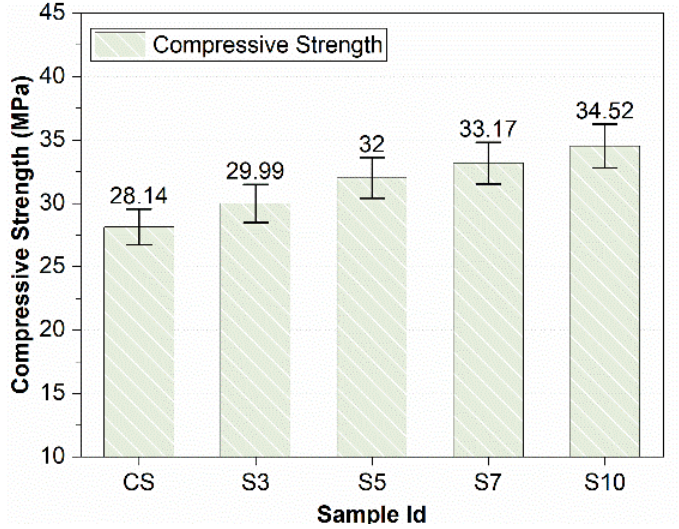
Figure 4. Compressive Strength of Modified Concrete.